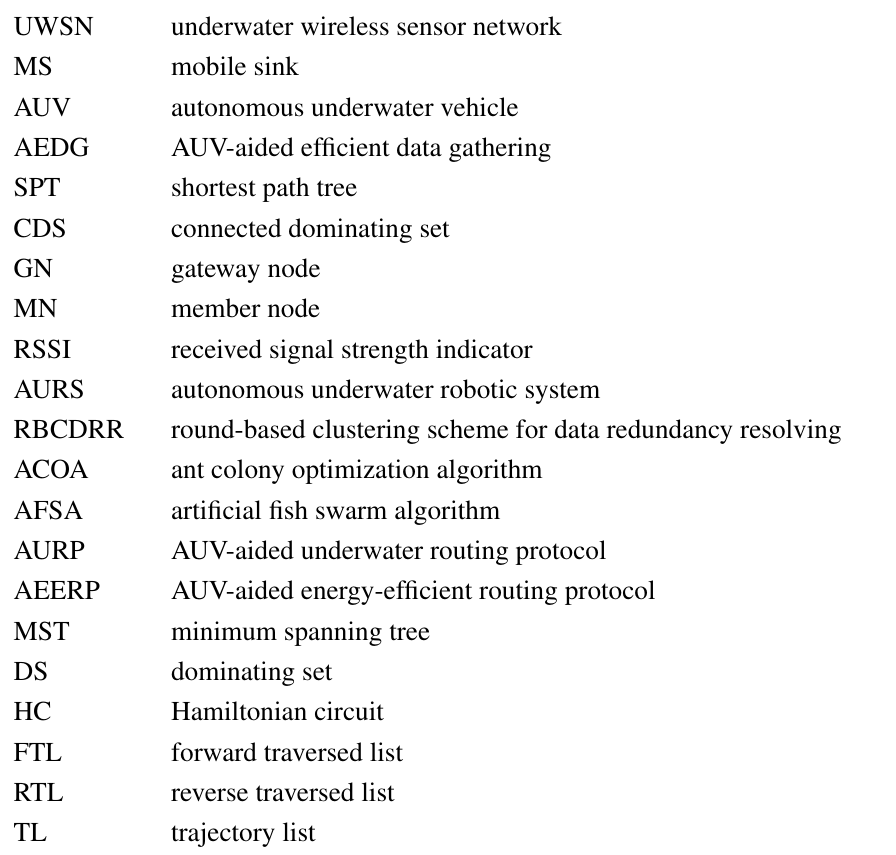
Table E1. List of